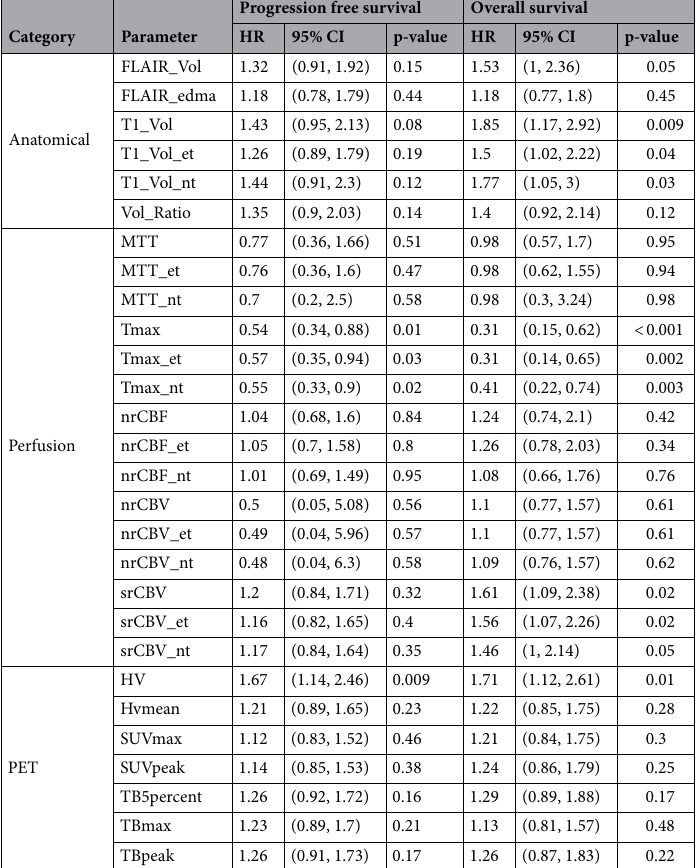
Table 3. Univariate proportional hazards models of PFS and OS.